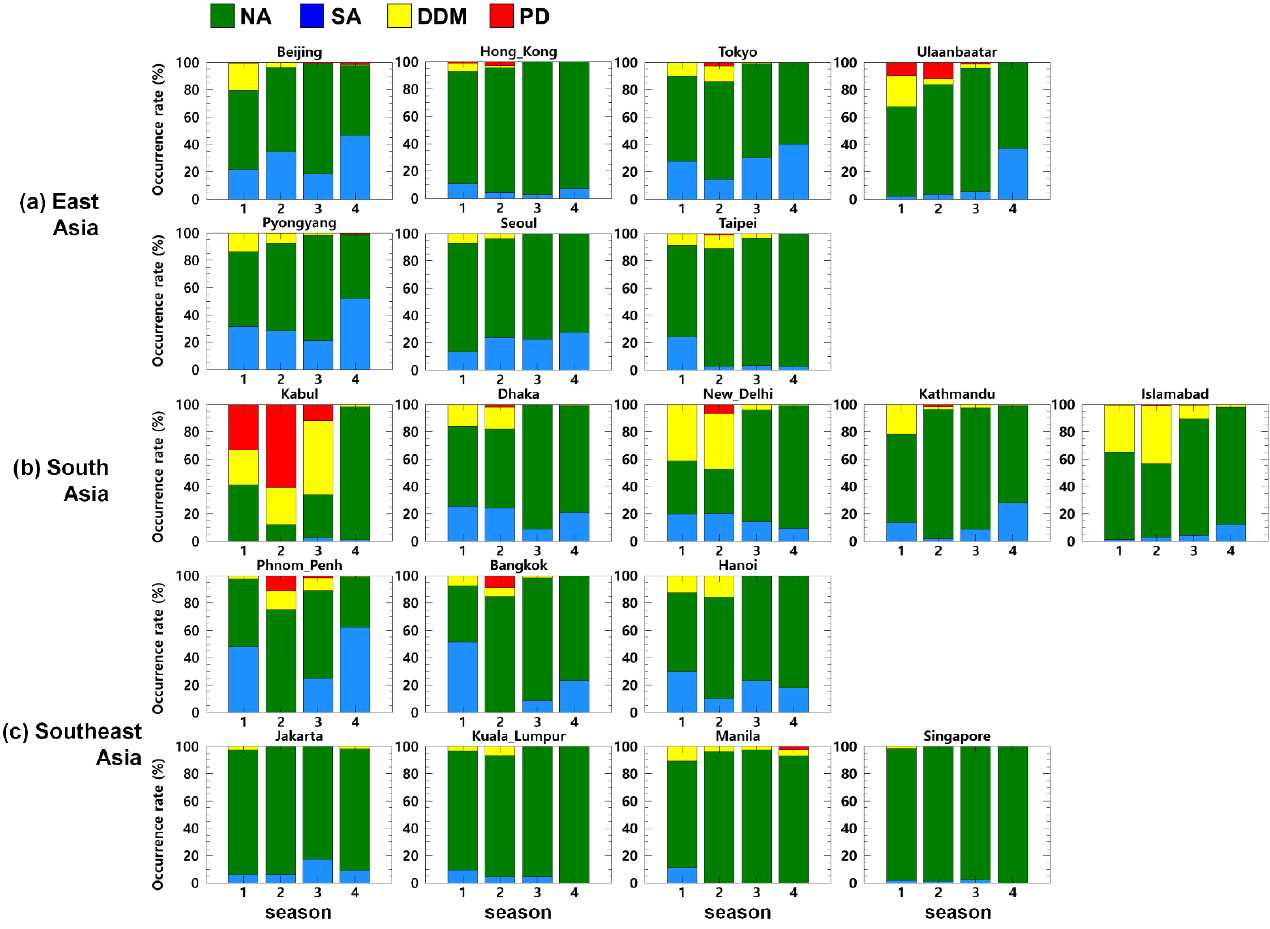
Figure 5. Seasonal occurrence rates for aerosol types detected by the RF model in ( a ) East Asia, ( b ) South Asia,